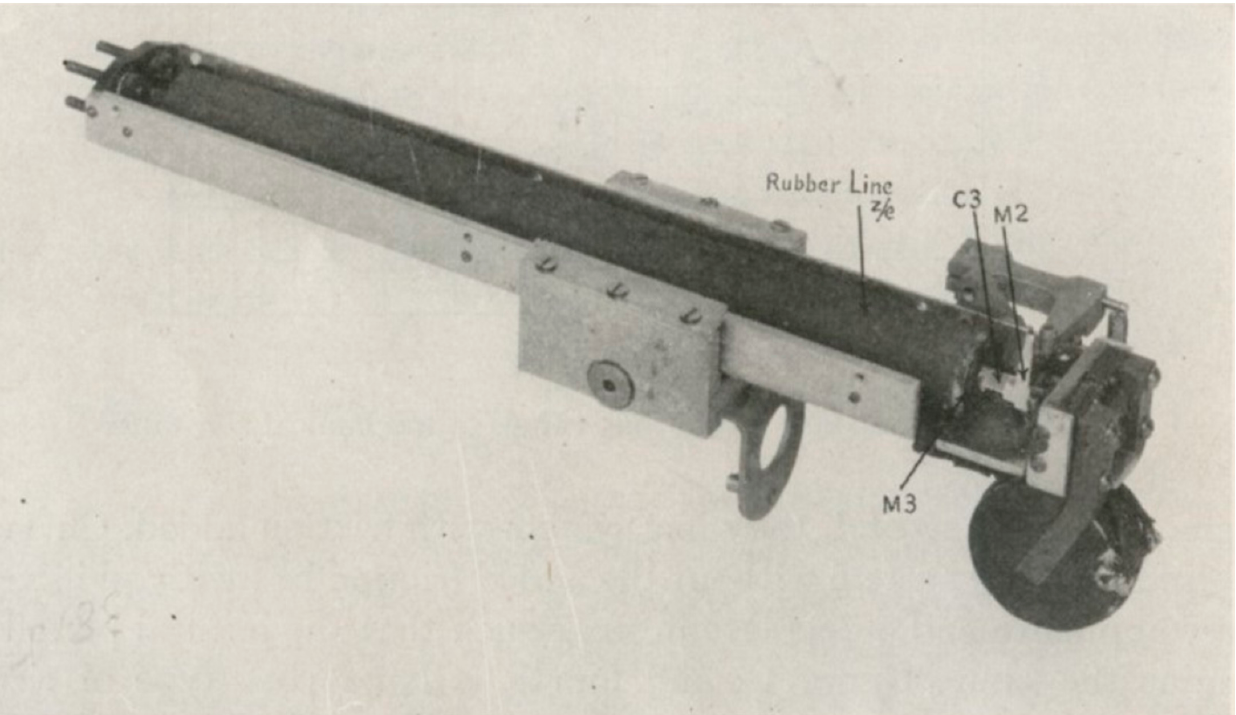
Figure 8. Bell Labs electromagnetic cutter used in the Westrex system.